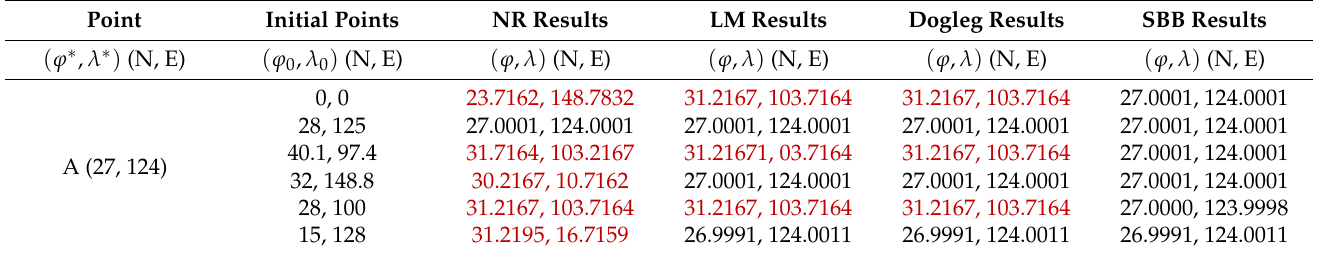
Table 4. Convergence results of conventional algorithms under different initial points. Point Initial Points NR Results LM Results Dogleg Results SBB